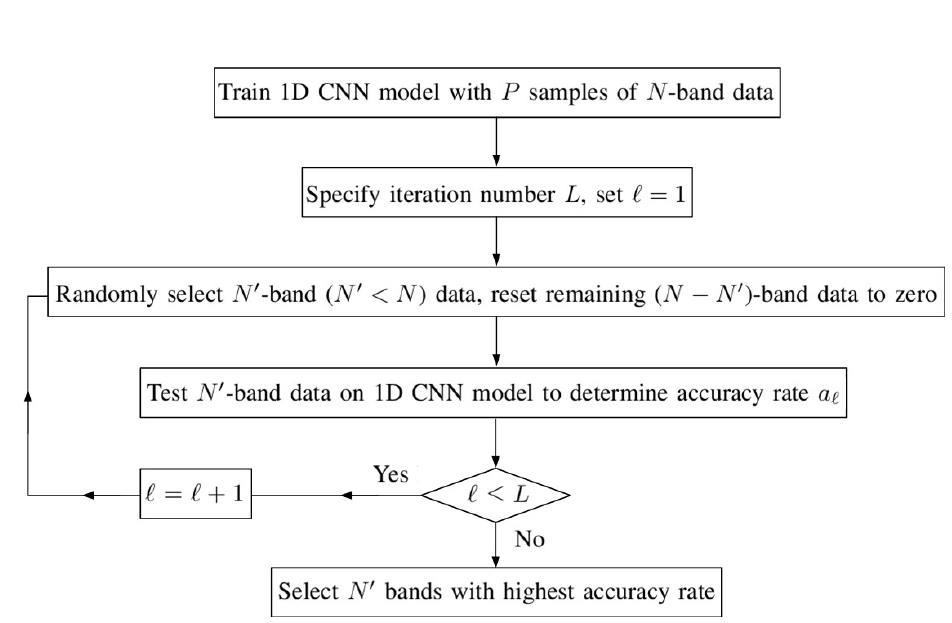
Figure 6. Flowchart of band selection (BS) approach based on CNN (BSCNN).